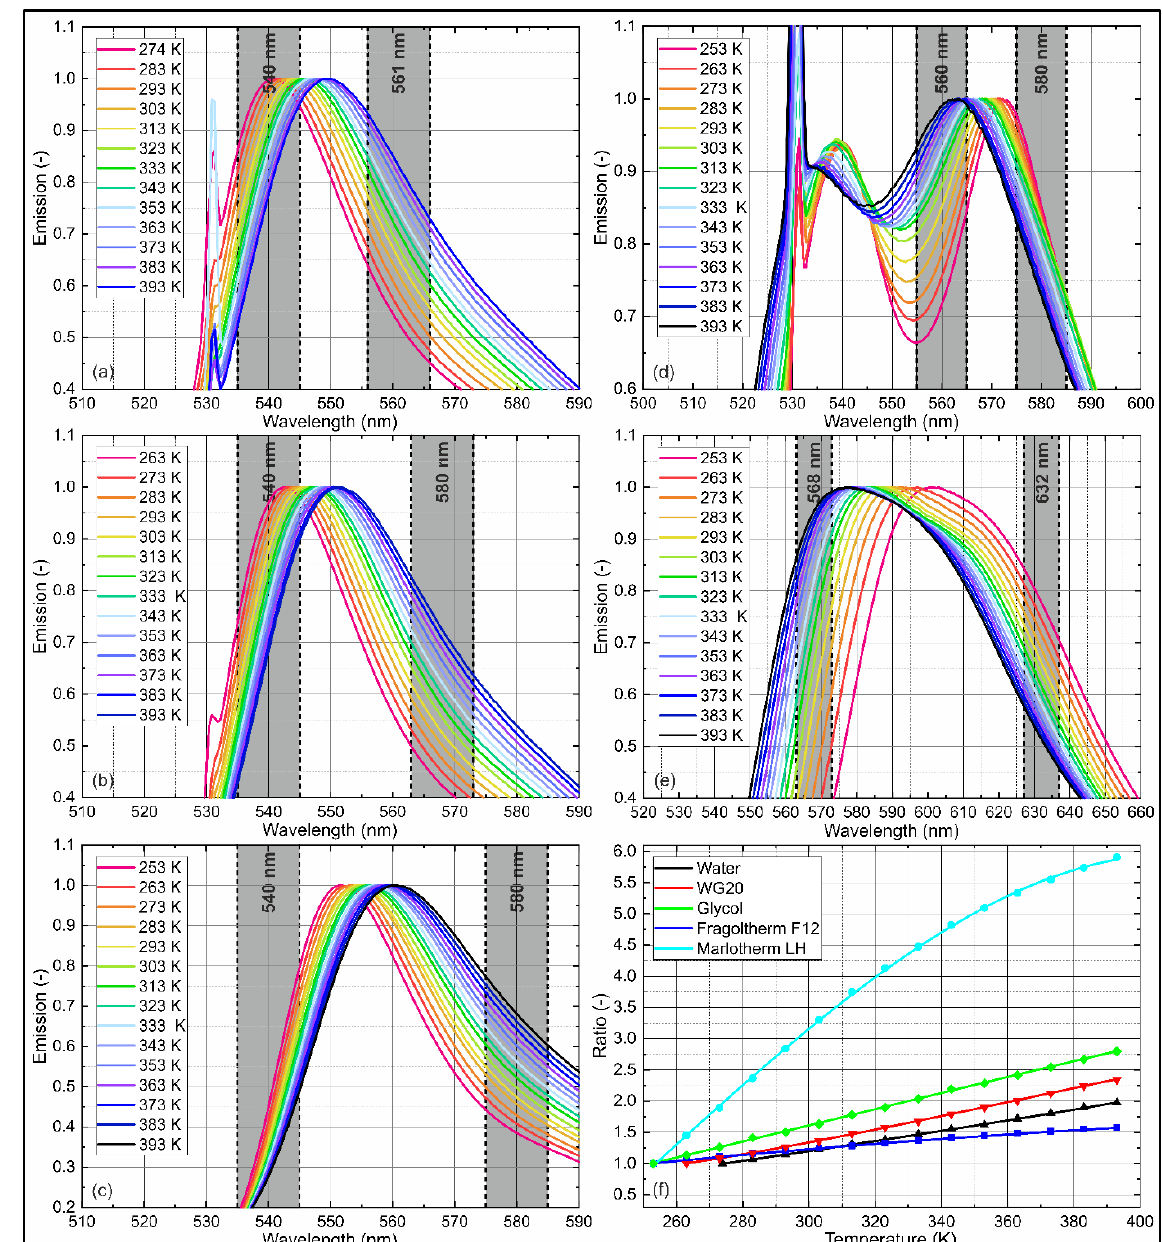
Figure 5. Normalized emission spectra of Eosin-Y/Nile red (9.38 mg/L) in various solvents (( a ): wa- ter, ( b ): WG20, ( c ): glycol, ( d ): Fragoltherm F12, ( e ): Marlotherm LH) at various temperatures with